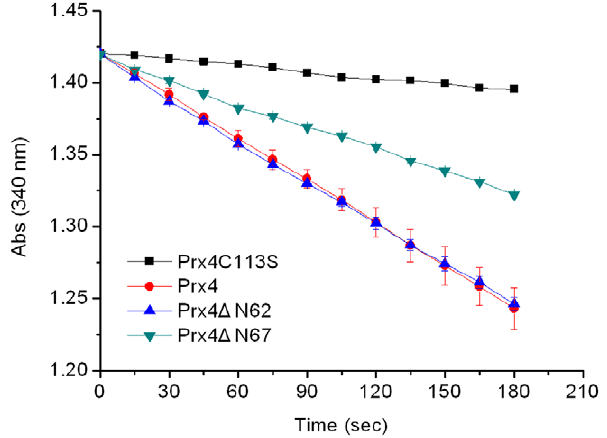
Figure 2. Peroxidase activity assays. Assays were performed with Prx4 (red circles), Prx4 D N62 (blue triangles), Prx4 D N67 (cyan inverted triangles) and Prx4C113S (black squares).